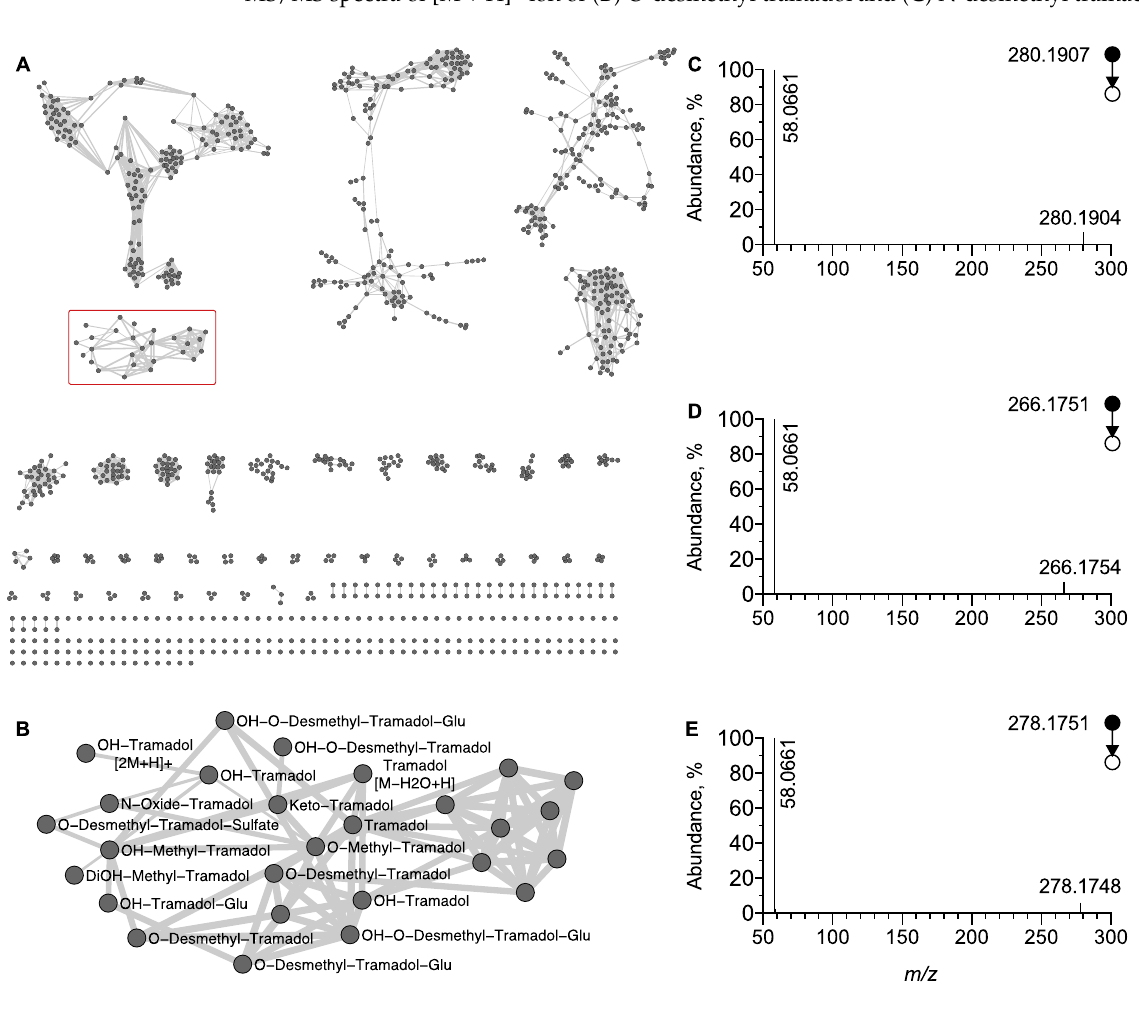
Figure 3. Molecular network generated under positive ion mode. ( A ) Global overview and ( B ) focus on the cluster of tramadol-related metabolites (C1 displayed as redbox). MS/MS spectra of [M + H] + ion corresponding to ( C ) OH-tramadol, ( D ) O-desmethyl tramadol, and ( E ) keto tramadol, respectively. The peak at m / z 58.0660 displayed on each MS/MS spectra facilitated the clustering in the MN.